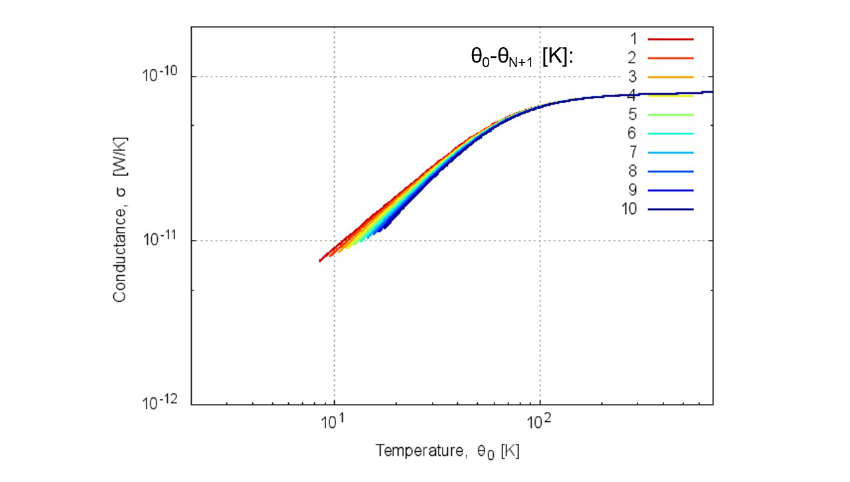
Figure 7. Temperature dependences of thermal conductance calculated by Equation (7). The parameters 1, 2, . . . 10 with unit of degrees Kelvin in the graph mean temperature differences θ 0 − θ N + 1 between the left and right